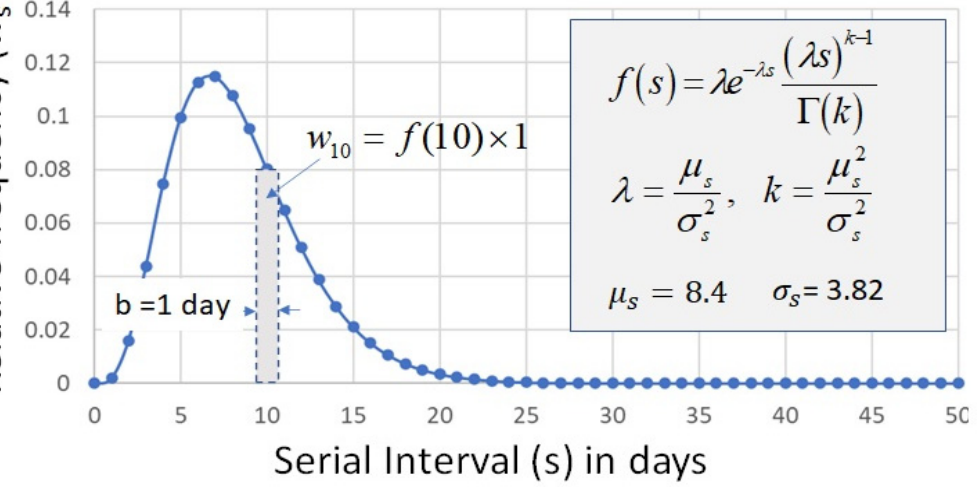
Figure 4. Typical plot of w s factors vs serial interval constructed based on a gamma distribution. The main parameter values (k and λ ) of the distribution can be defined by calculus based on the provided mean ( µ s ) and standard deviation ( σ s ), which should be obtained by experimentation.